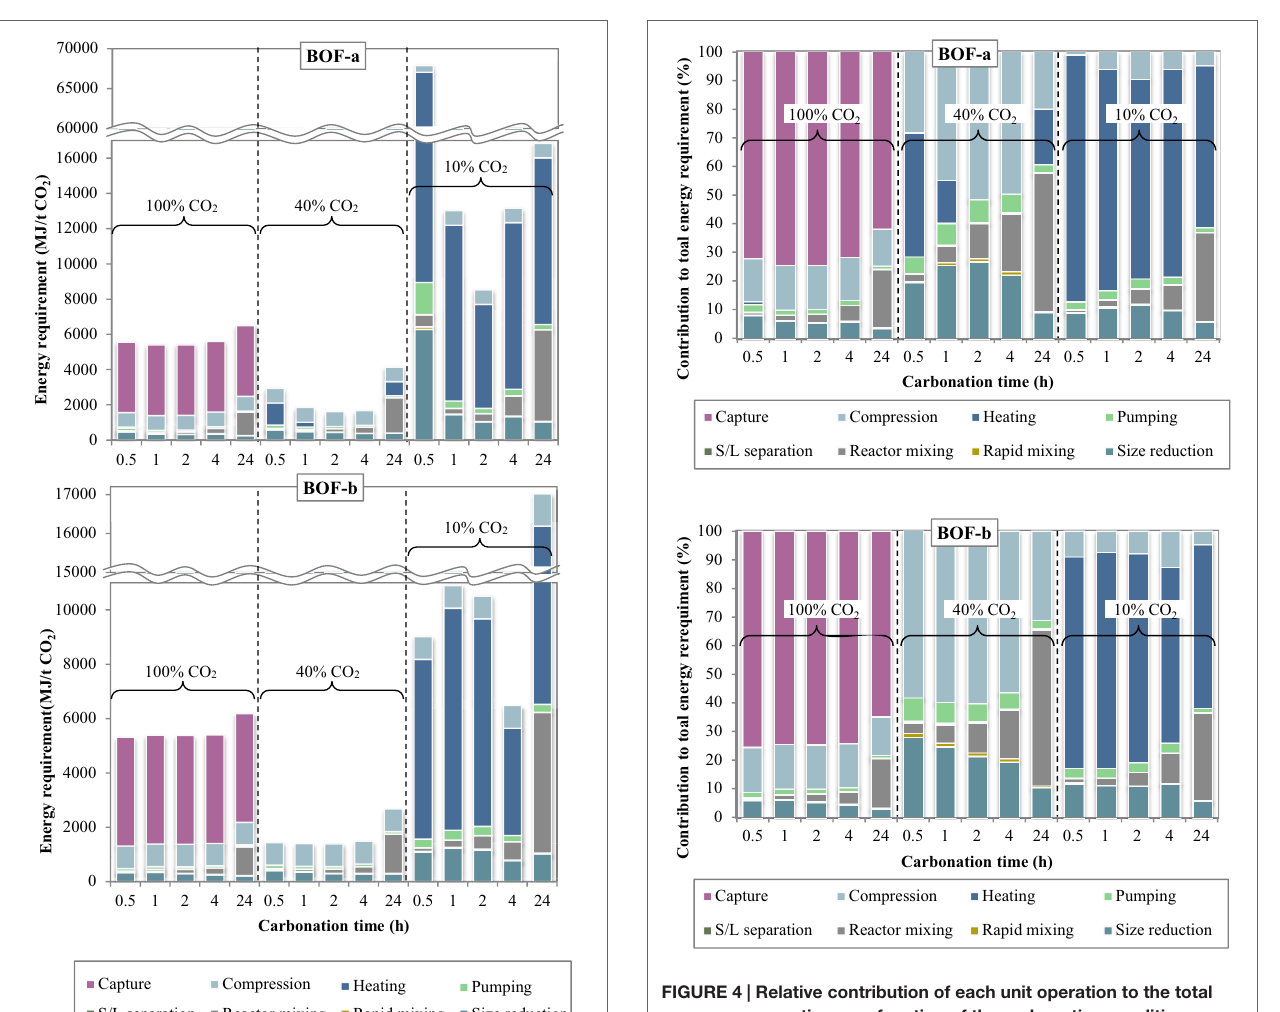
FigUre 4 | relative contribution of each unit operation to the total energy consumption as a function of the carbonation conditions (slurry-phase route) .